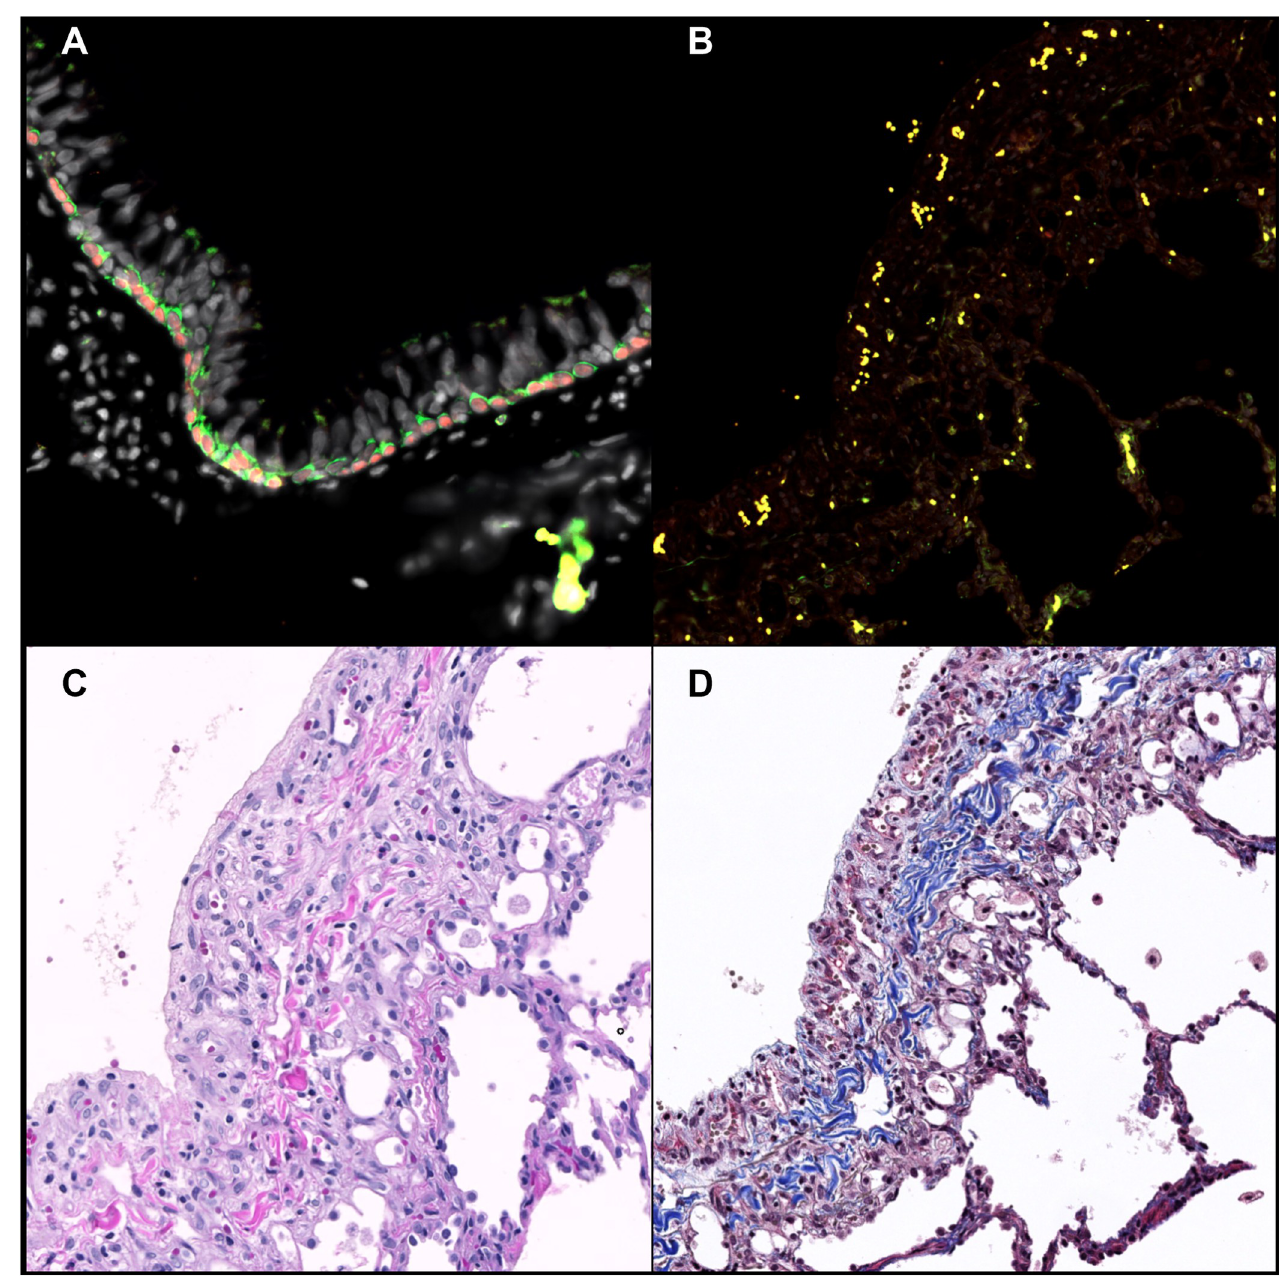
Fig 10. Absence of regenerative activity at 28 days post-exposure. Immunofluorescence for the detection of bronchial epithelial progenitor cells. A) NJ48, lung. The epithelial lining of large airways (bronchi) has a basal layer containing progenitor cells characterized by cytoplasmic expression of cytokeratin 5 (green) and nuclear expression of p63 (red). B-D) KN90, lung alveoli. B) Progenitor cells are not observed in regions of pleuritis and pleural fibrosis with H&E (C) and trichrome (D). Bar = 100 μ